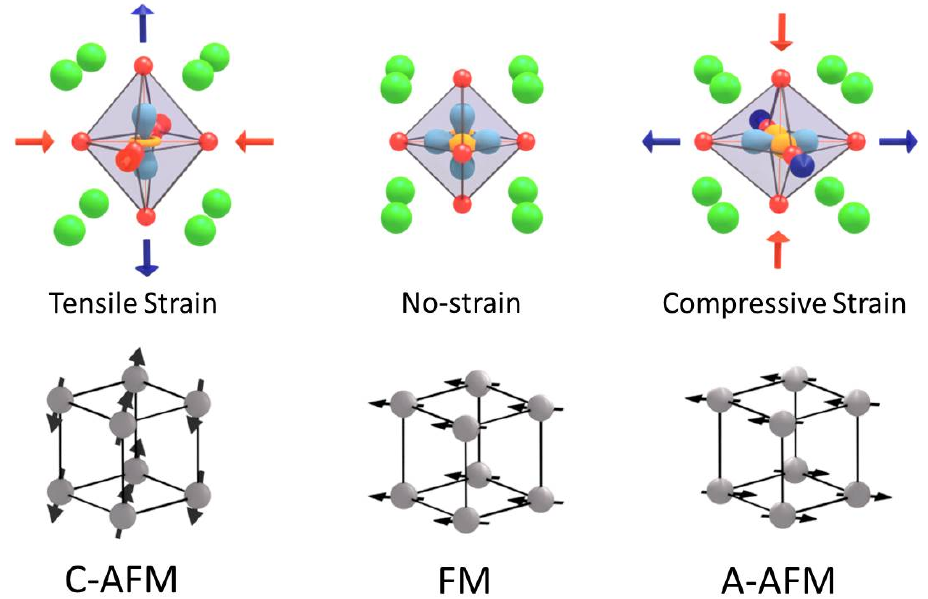
Figure 8. Orbital reconstruction and induced antiferromagnetic (AFM) ordering, due to tetragonal